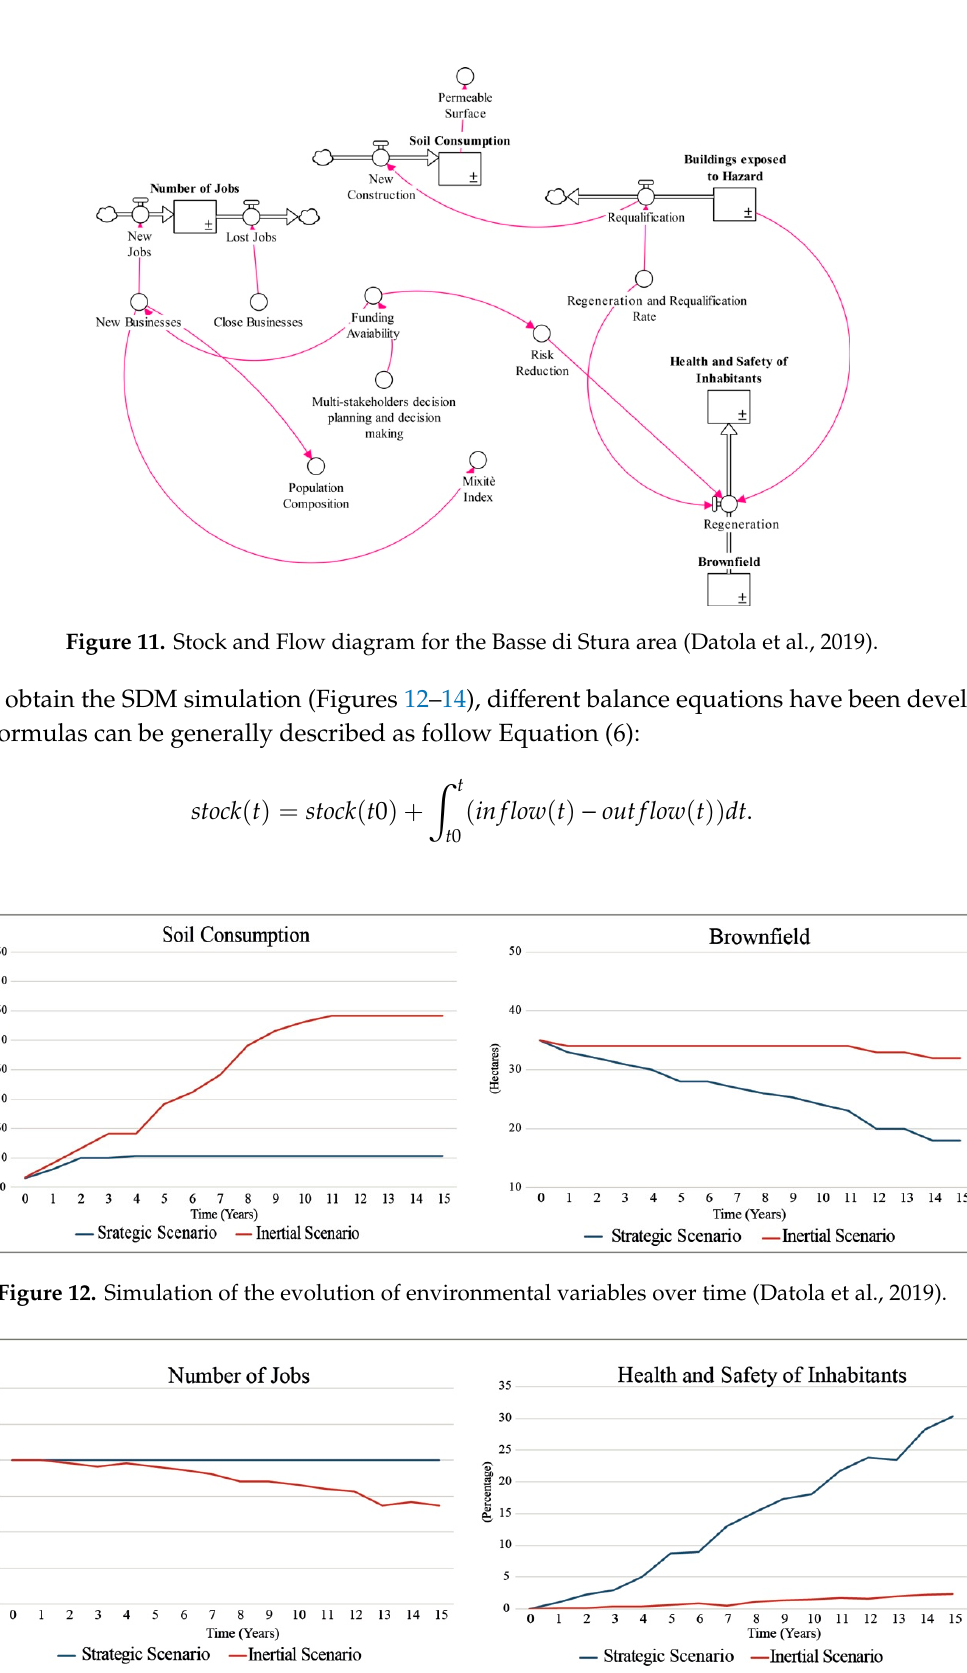
Figure 14. Comparative simulation of the evolution of environmental variables over time (Datola et al., 2019) . 6. Discussion We have shown how the inertial scenario and the strategic scenario have significant differences in the performances of “soil consumption” and “brownfields” (Figure 12), “health and safety of inhabitants” (Figure 13) and “number of buildings exposed to hazards” (Figure 14). In detail, the strategic scenario shows a more limited increase in soil consumption than the inertial scenario. This behavior is due to the different values assigned to the “regeneration and requalification rate” parameter. In fact, this parameter has a decreasing impact on “new construction”